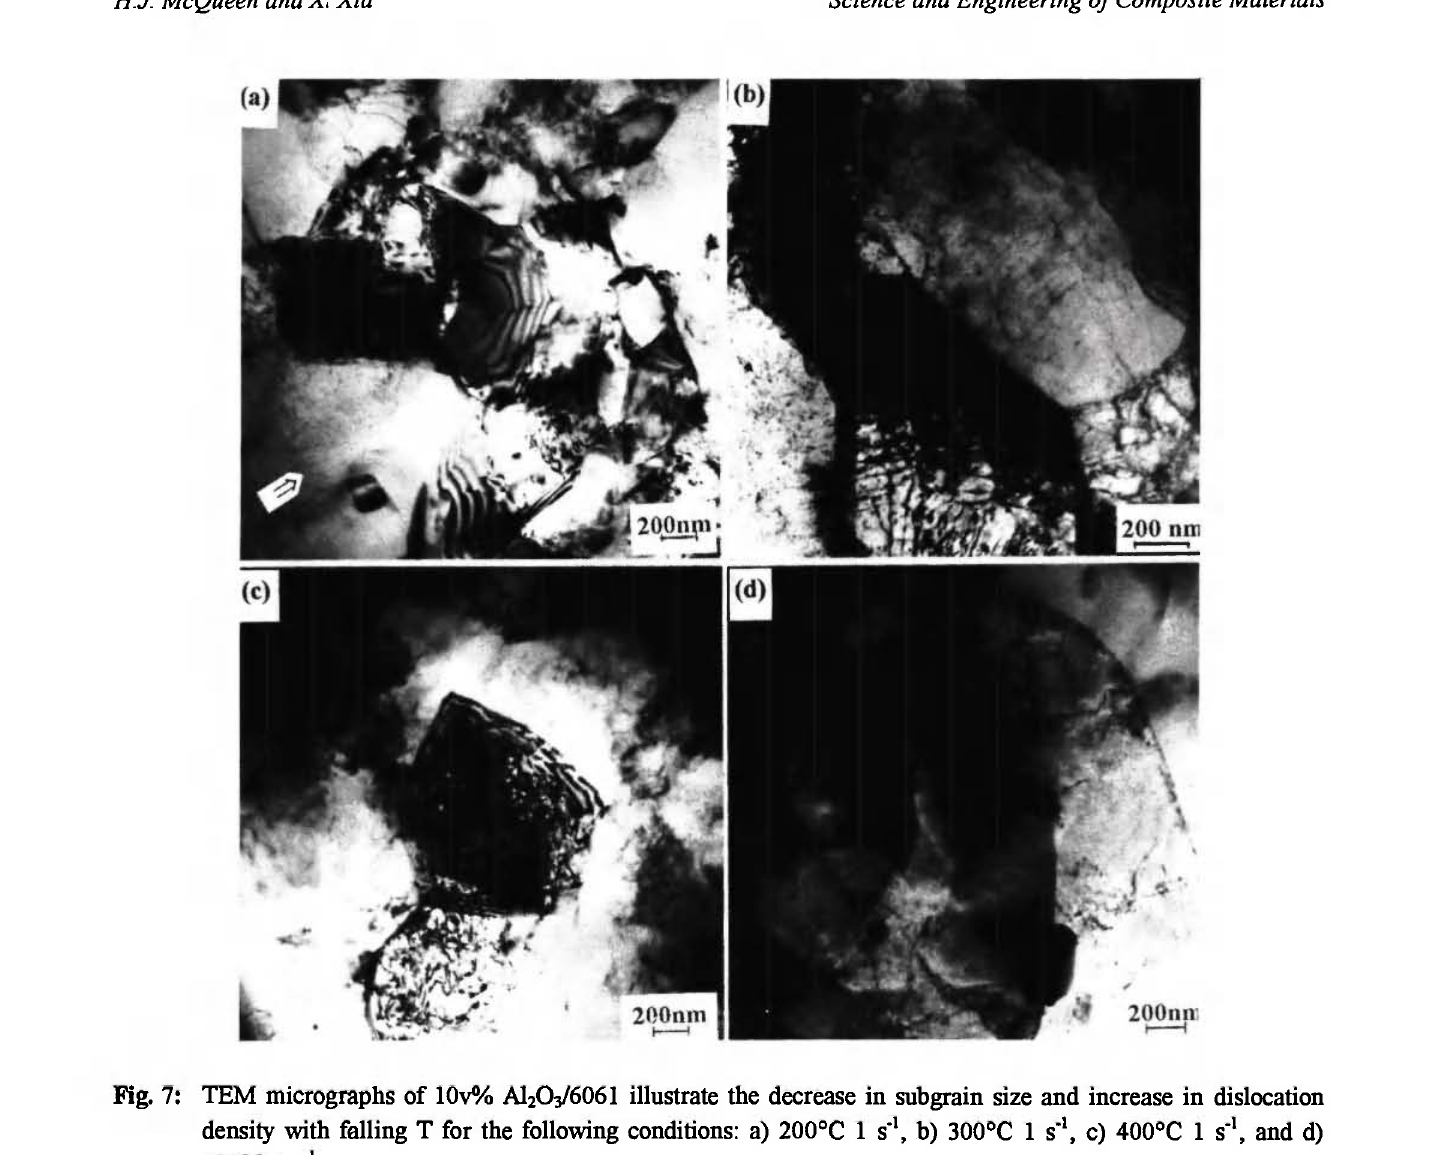
Fig. 7: TEM micrographs of 10v% AI2O3 /6O6I illustrate the decrease in subgrain size and increase in dislocation density with falling Τ for the following conditions: a) 200°C 1 s" 1 , b) 300°C 1 s"\ c) 400°C 1 s" 1 , and d) 500°C 1 s l